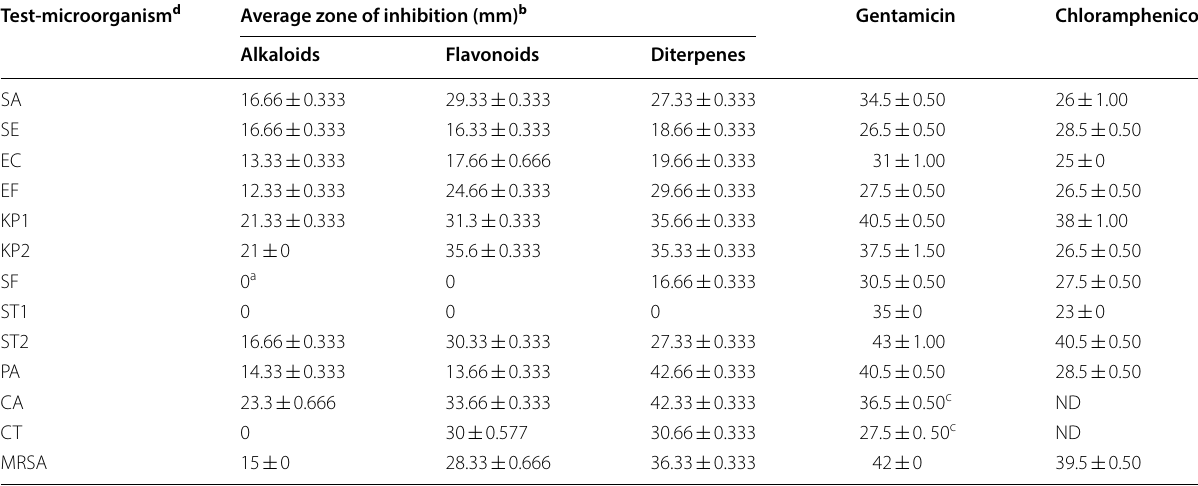
ND, not done a No activity b Values are expressed as mean